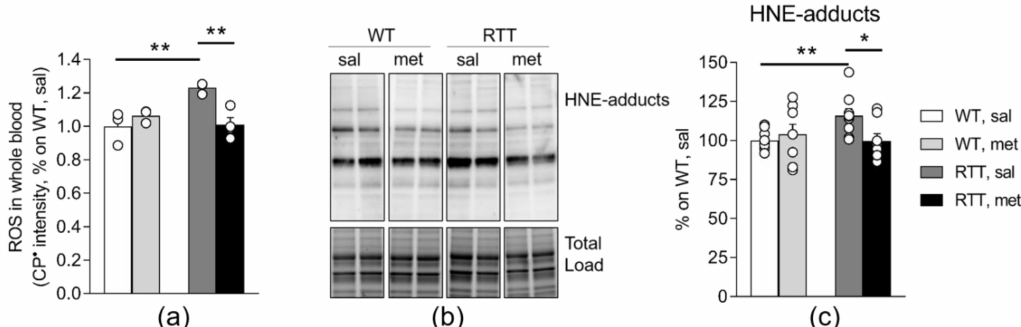
Figure 4. Metformin treatment rescues increased oxidative stress status in the brain and in the blood of RTT mice. ( a ) Blood ROS levels, measured as the intensity of formation of CP • by EPR, were significantly higher in RTT, sal mice compared to WT controls, confirming the occurrence of a pro-oxidant status in RTT mice. Metformin normalized this value in whole blood of RTT mice to the same level of WT controls. N = 3–4. One subject of the experimental group RTT, sal was identified as outlier and